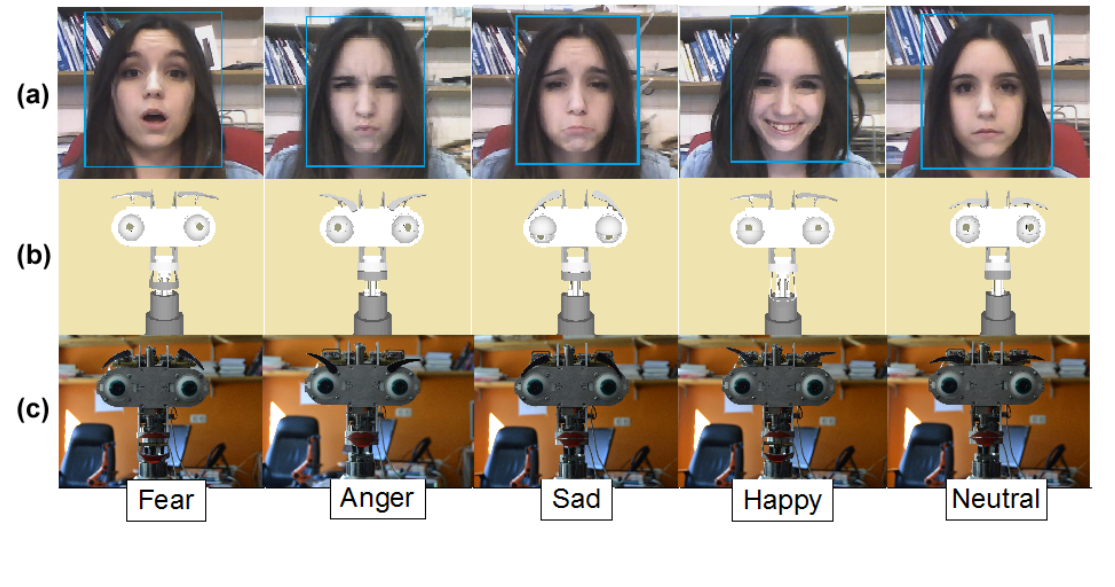
Figure 15. ( a ) Facial expression of the user; ( b ) model-based representation of each emotional state; and ( c ) imitation of each facial expression by the robotic head, Muecas.